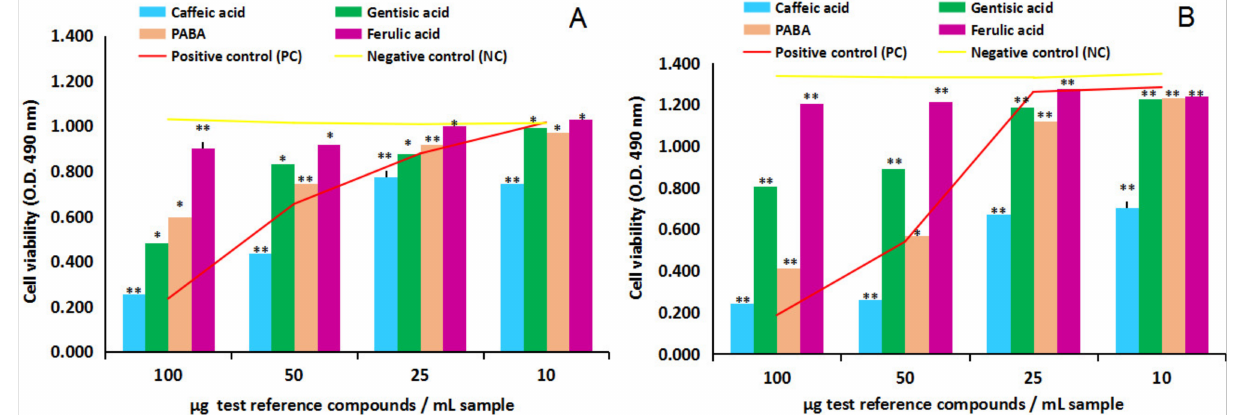
Figure 5. Effect of test reference compounds (caffeic acid, gentisic acid, ferulic acid and para- aminobenzoic acid/PABA) on human tumor brain cell line U87, in anti-proliferative MTS assay. ( A ) U87 cell line viability after 24 h of exposure to test reference compounds. ( B ) U87 cell line viability after 48 h of exposure to test reference compounds. Data were the mean of three replicates (n = 3). Note: * = results without statistical significance ( p > 0.05); ** = results with statistical significance ( p <